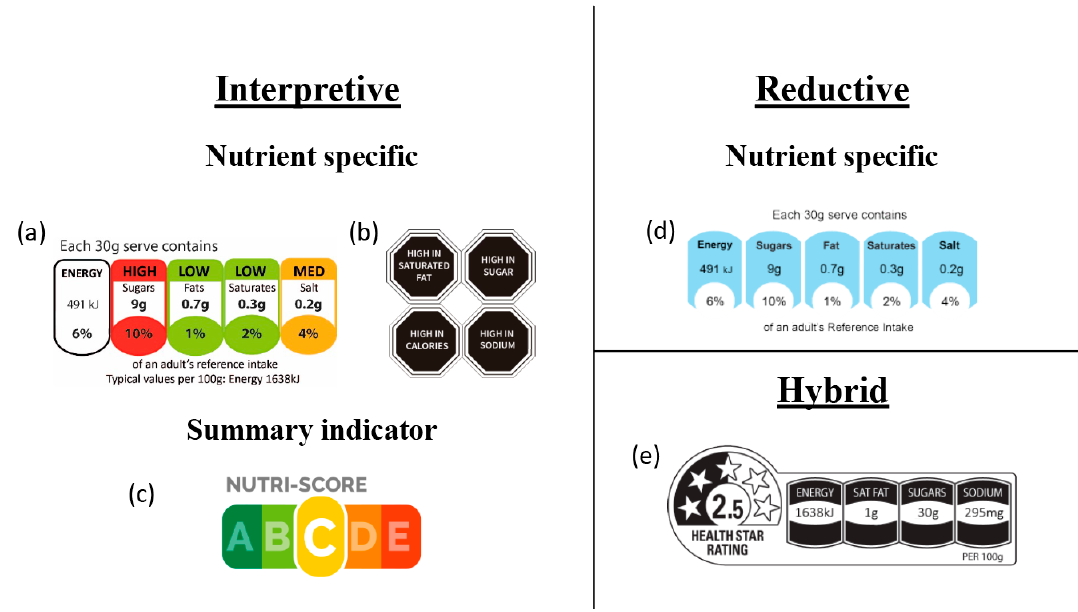
Figure 1. Examples of different front-of-pack label (FoPL) formats and their classifications: ( a ) multiple traffic lights; ( b ) warning labels; ( c ) Nutri-Score; ( d ) reference intakes; and ( e ) health star rating.